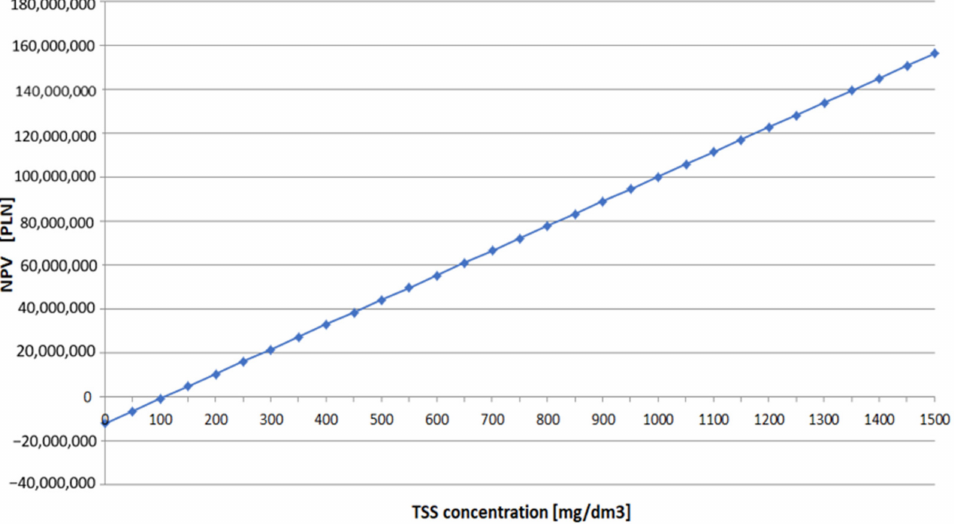
Figure 3. The sensitivity analysis of NPV in relation to the level of TSS